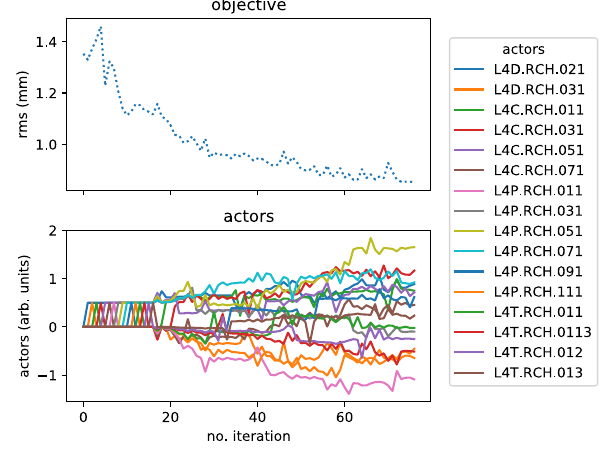
FIG. 12. Optimization with COBYLA of the LINAC4 trajec- tory correction problem in the horizontal plane. The algorithm converged after around 70 iterations.